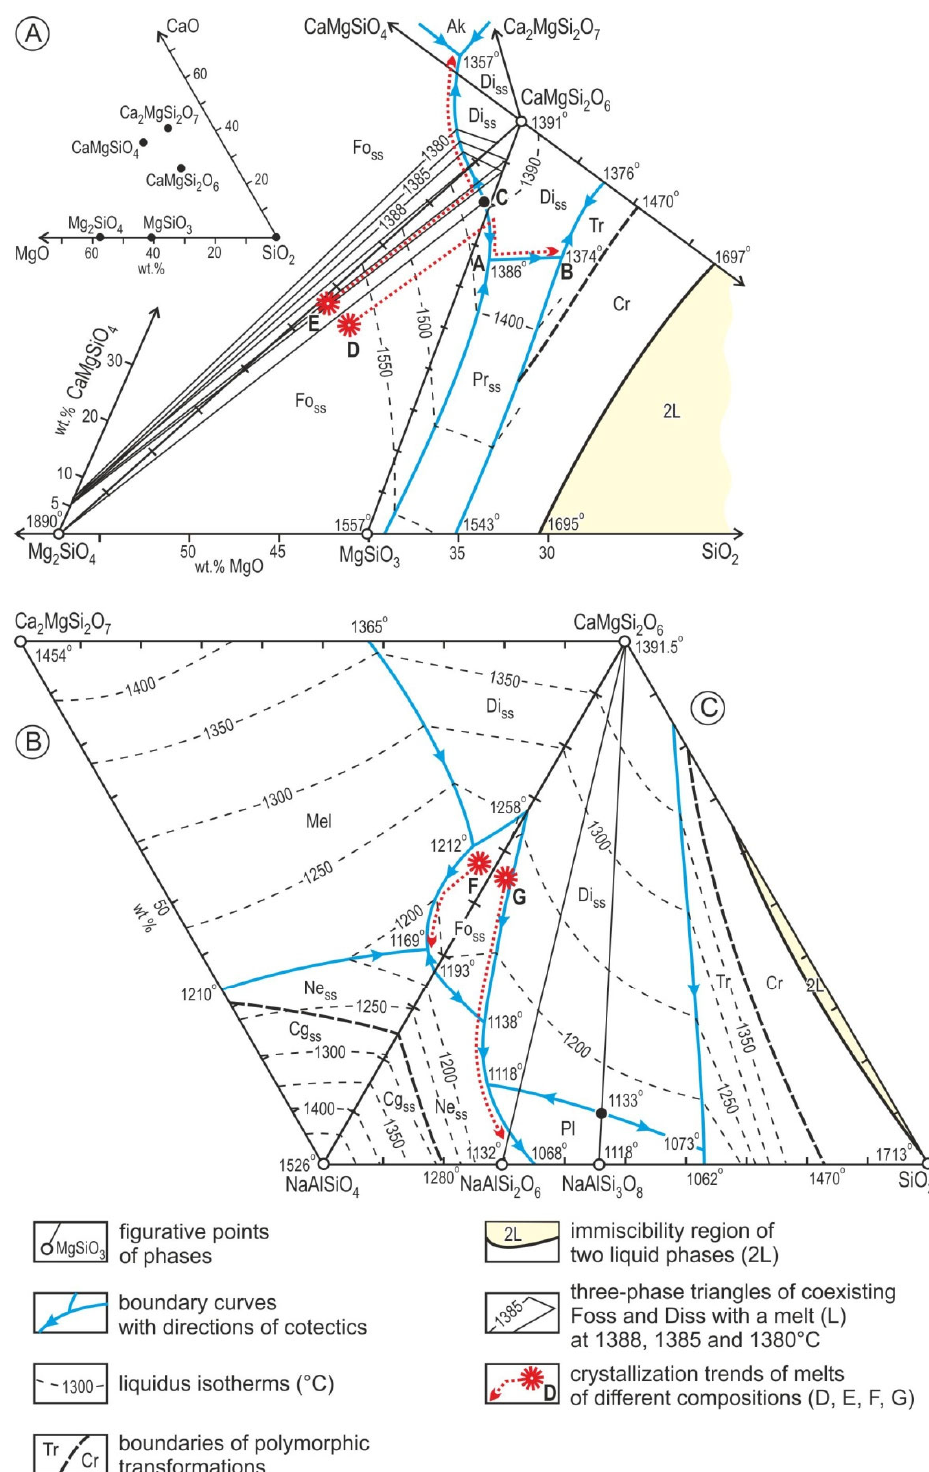
Figure 8. Possible crystallization trends of various rock associations of the Tomtor massif on multidiagrams of Fo–Ak–Di–Ne–Q. Diagrams: Fo–Di–SiO 2 ( A ) according to [36], Ne–Ak–Di ( B ) according to [37], Ne–Di–SiO 2 ( C ) [38]. The inset shows the positions of main minerals in the MgO–CaO–SiO 2 system. Fields of crystallization of phases: Fo—forsterite; Di—diopside; Pr—protoenstatite; Ak—akermanite; Cg—carnegieite; Ne—nepheline; Pl ‐ plagioclase; Mel—melilite; Ab—albite; Cr—cristobalite and Tr—tridymite. Other explanations in the main text.